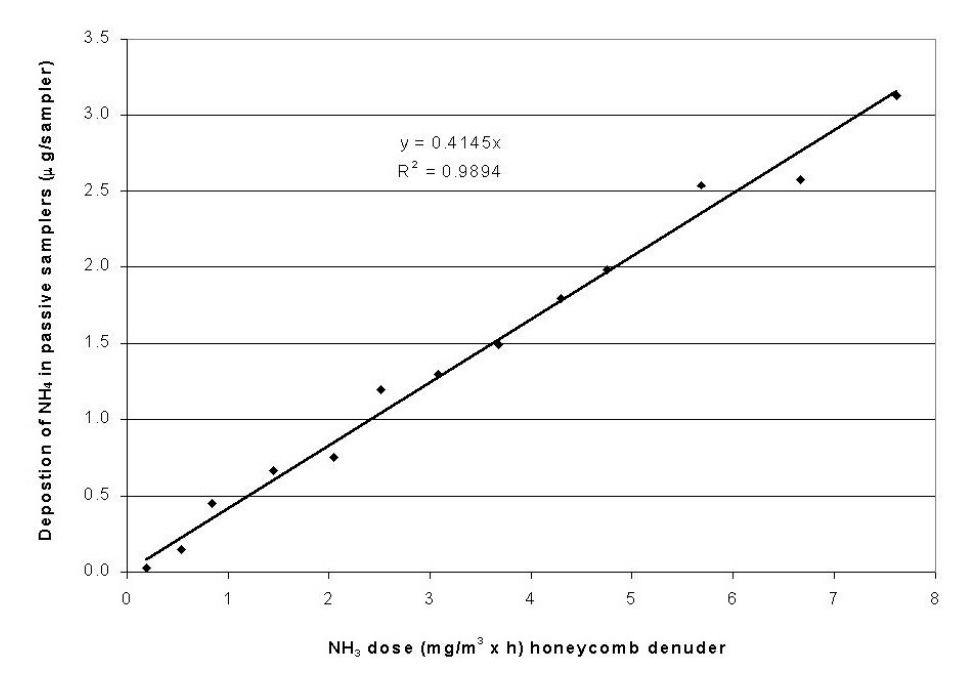
FIGURE 2. Comparison of ammonia passive samplers (µg of NH 4+ deposited per sampler) to ammonia dose (mg m -3 × h) measured with a honeycomb denuder